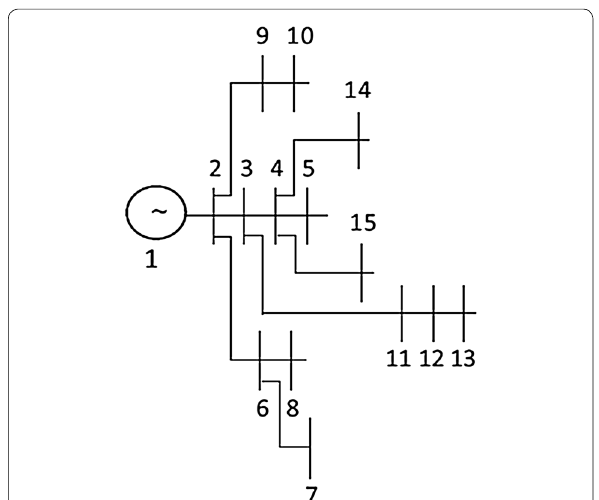
Fig. 1 Single line diagram of 15-bus system